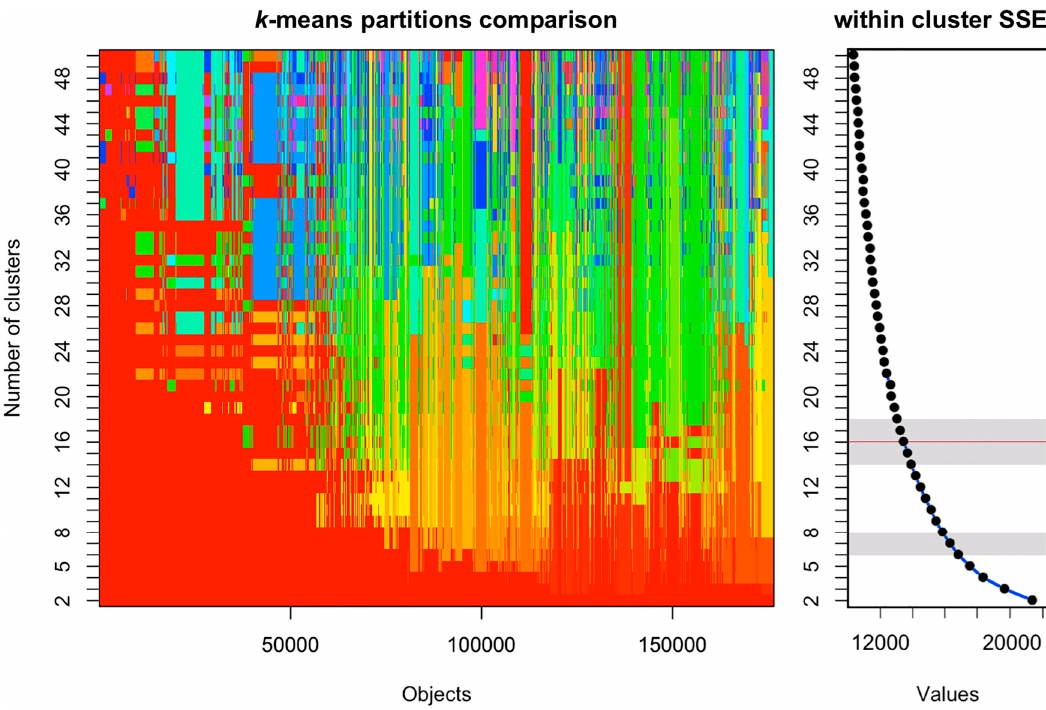
Figure 11. Determining the value of k : Comparison of different k -means clustering.